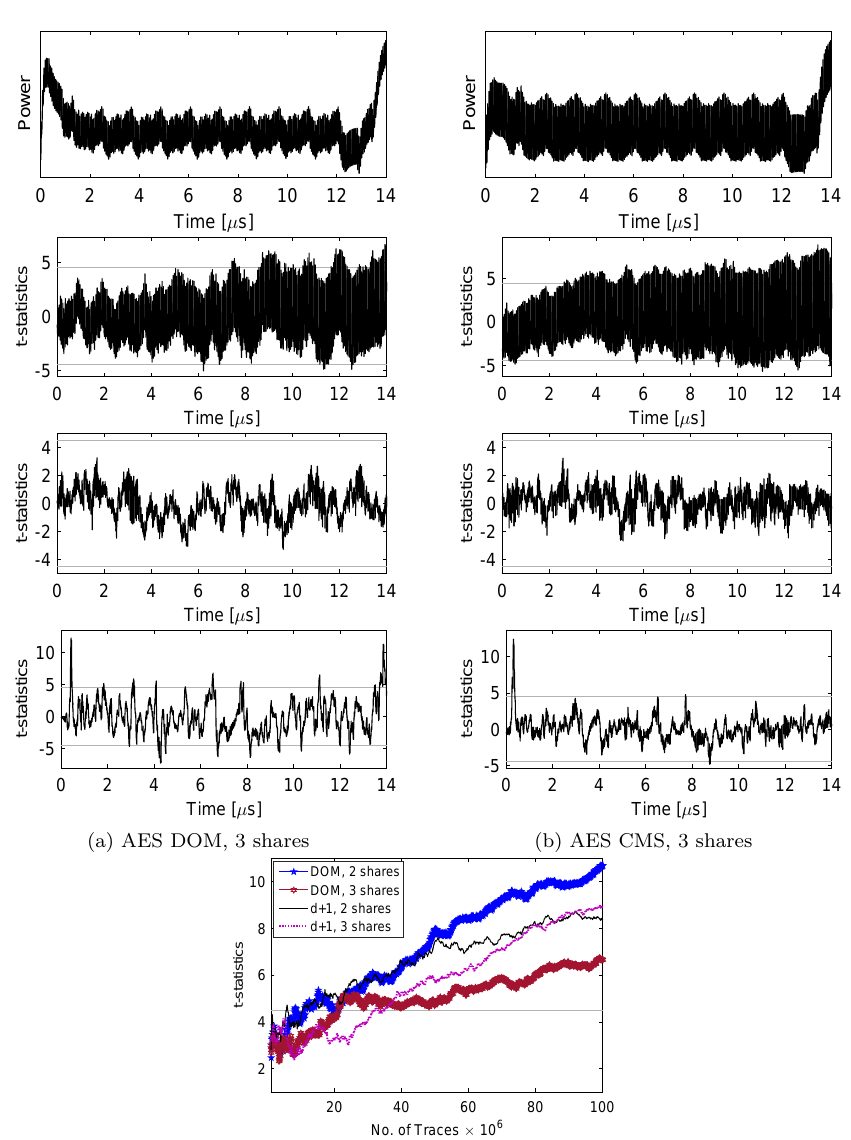
Figure 15: Case study 4: AES, DOM & CMS, 3 shares, Vdd 1.2 v, shunt 1.0 Ω, clock 24 MHz, room temperature, (top) average of 1000 power traces, (2nd row) 1st-order, (3rd row) 2nd-order and (4th row) 3rd-order t -test results using 100 million traces, (bottom) max ( | t | ) 1st-order over the number of